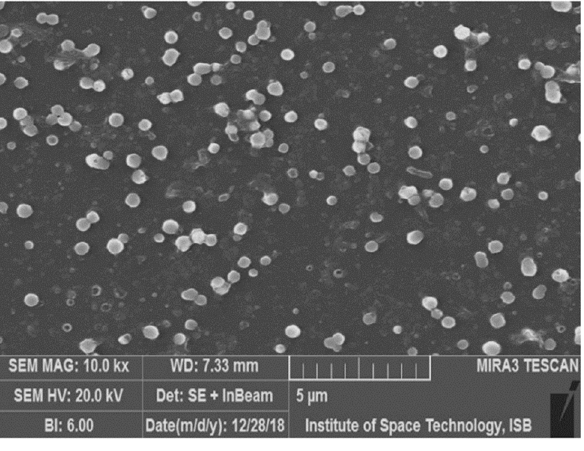
Figure 2. Scanning electron microscope (SEM) image of Precirol lipid nanoparticles with spherical morphology loaded with SIM .